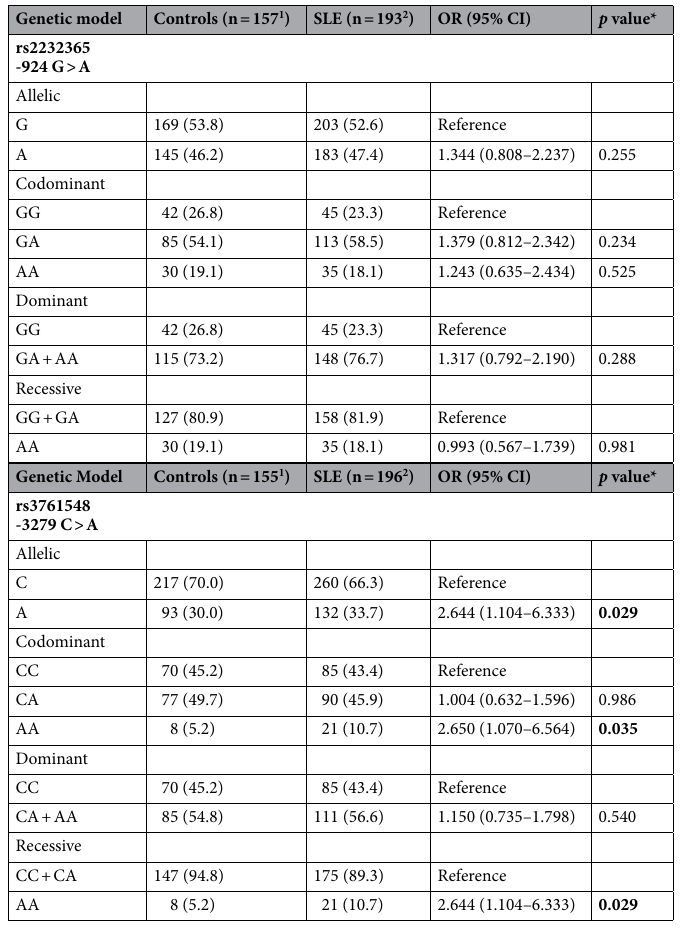
Table 2. Distribution of FOXP3 -924 G > A (rs2232365) and -3279 C > A (rs3761548) genotypes and allelic frequencies among patients with systemic lupus erythematosus (SLE) and controls. χ 2 : results of analyses of contingency tables. Data were expressed as absolute number (n) and percentage (%). Bold values represent statistically significant values. *Adjusted by age and ethnicity. 1 Hardy–Weinberg equilibrium χ 2